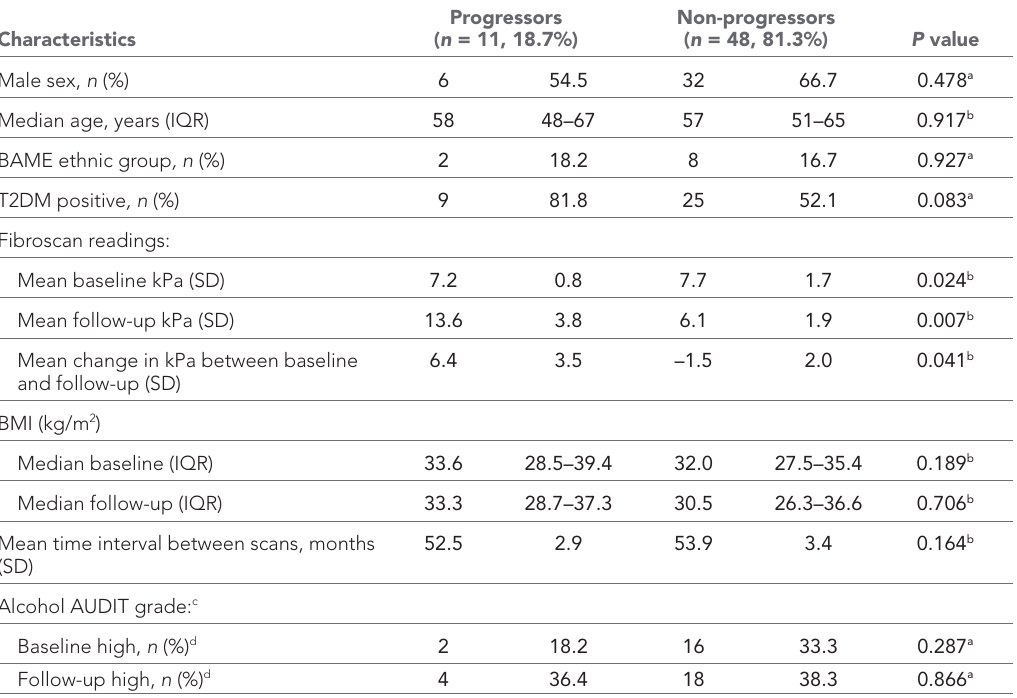
Table 2 Characteristics of patients who, at follow- up, had either progressed their liver fibrosis stage (progressors) or their liver fibrosis stage had remained the same or reversed (non- progressors)